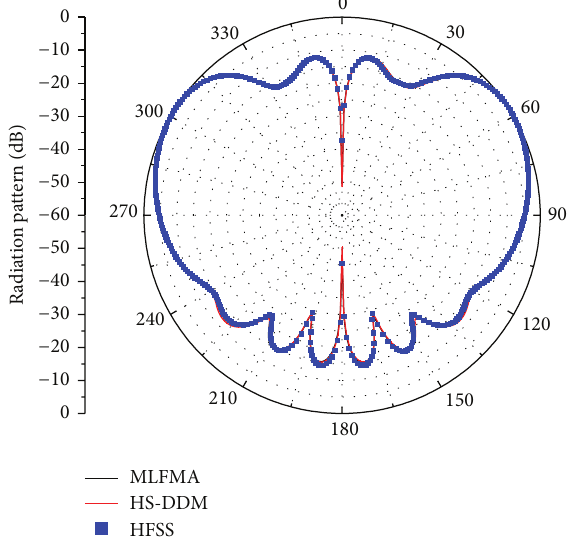
Figure 7: The normalized radiating pattern of the monopole antenna on a plate at 2.0